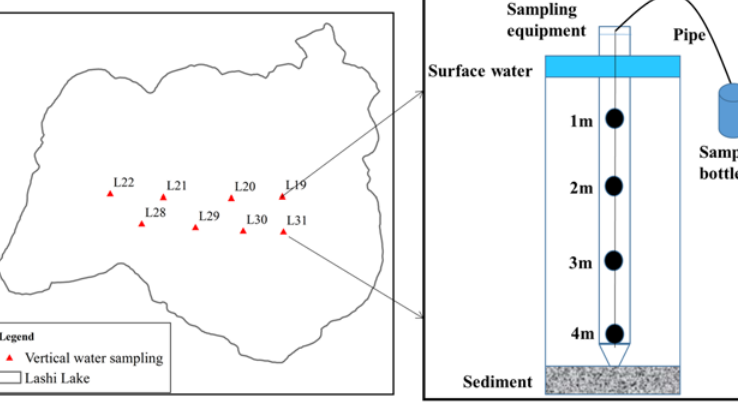
Figure 2. Schematic diagram of the locations of profiles in the middle part of Lashi Lake.